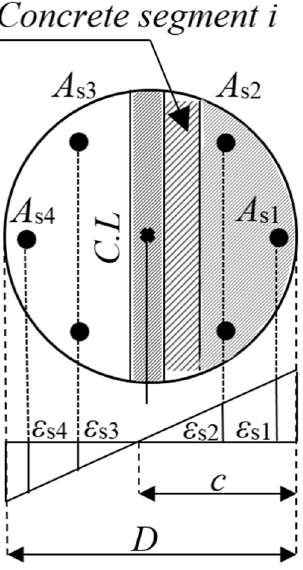
Figure 11. Strain distribution in column cross-section under axial – flexural loading.